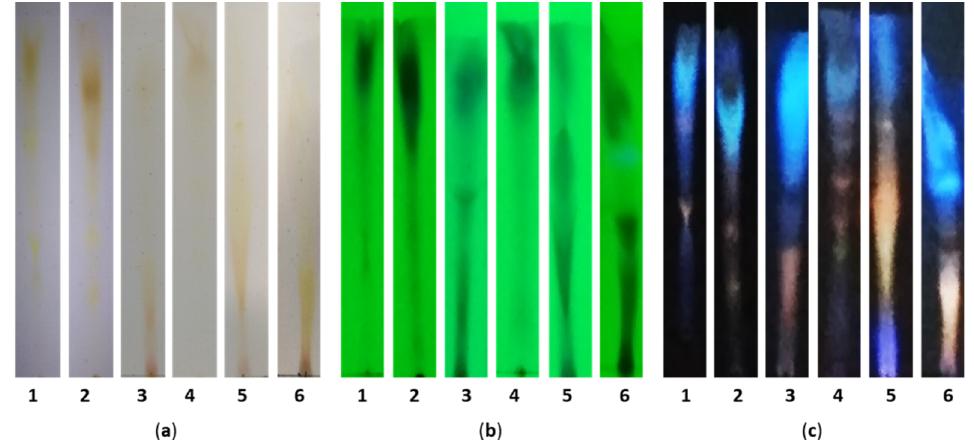
Figure 7. Silica gel TLC showing the separation of the pigments mixtures obtained from the best conditions selected for the comparative analysis: 1—culture medium A under SmF; 2—culture medium D under SmF; 3—extracellular medium (EM) obtained using culture medium A under SmFi; 4—ethanolic extract (EE) obtained using culture medium A under SmFi; 5—ethanolic extract (EE) obtained using culture medium D under SmFi; and 6—ethanolic extract (EE) obtained using culture medium A under SSF. ( a ) TLC photographed under visible light; ( b ) TLC exposed to UV light at 254 nm; and ( c ) TLC exposed at 366 nm.